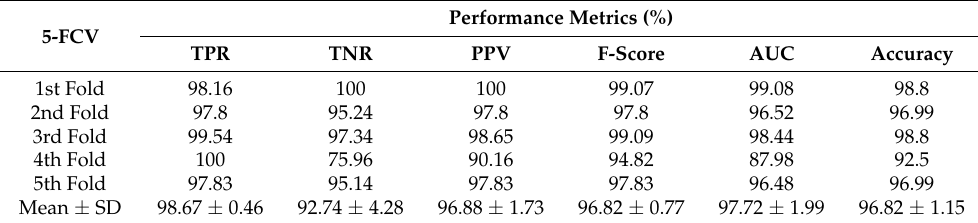
Table 11. Classification performance of the proposed model on Adagrad optimizer.